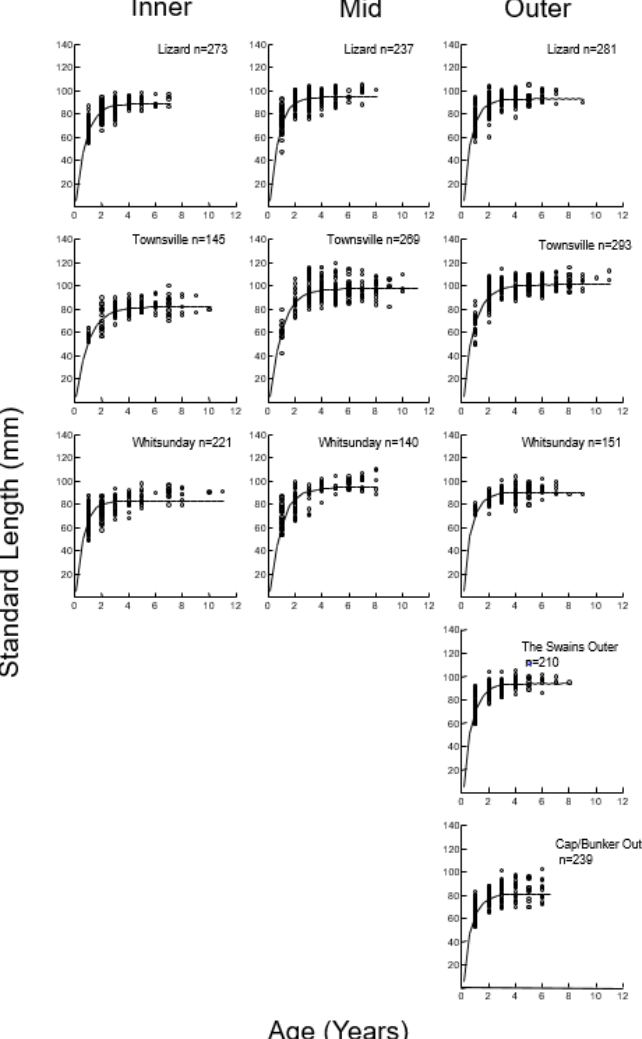
Figure 5. Von Bertalan ff y growth curves for A. polyacanthus collected with distance across the shelf and with latitude (reefs pooled within distances at each